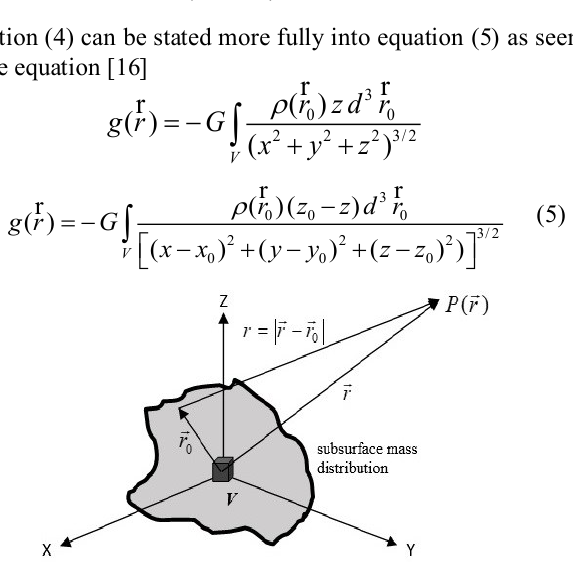
Fig. 3. The gravitational potential at point P on the Earth's surface due to the continuous distribution of mass in the subsurface [16]